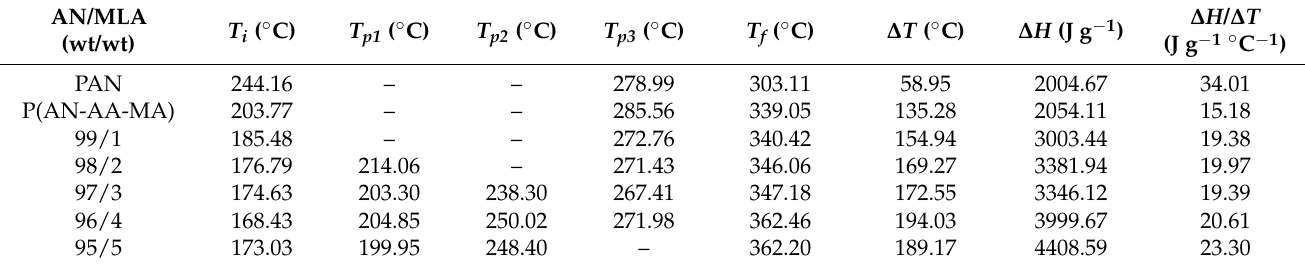
Figure 11. DSC of PAN, P (AN-AA-MA), and P (AN- co -MLA) with different feed ratios of AN/MLA: ( a ) PAN, ( b ) AN/MLA = 99/1 (wt/wt), ( c ) AN/MLA = 98/2 (wt/wt), ( d ) AN/MLA = 97/3 (wt/wt), ( e ) AN/MLA = 96/4 (wt/wt), ( f ) AN/MLA = 95/5 (wt/wt), ( g ) P (AN-AA-MA). Table 6. Parameters for DSC curves of PAN, P (AN-AA-MA), and P (AN- co -MLA) copolymers measured under N 2